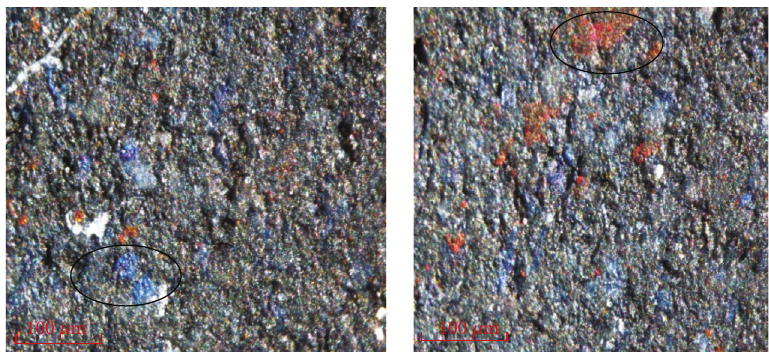
Figure 6: Local enlarged view of core slice A-1 after water fl ooding.